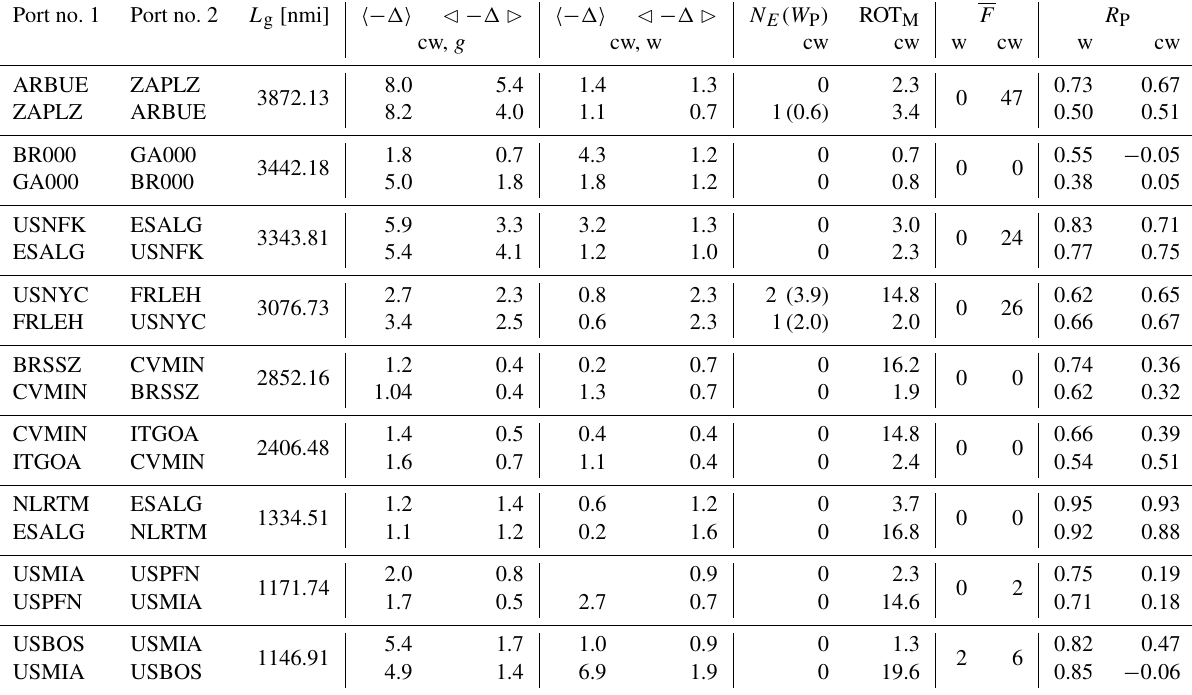
Table 7. Database of routes. L g is the length of the geodetic track on the graph. (cid:49) is a shortcut for the EEOI saving. The (cid:104)·(cid:105) operator denotes the annual mean. The (cid:67) · (cid:66) is the mean annual value of the standard deviation. Corresponding values are given (in %). The second header line specifies the type of tracks. The other columns contain the number of tracks N E with intentional speed reduction and the maximum percent fraction of track waypoints affected (W P ) – for the w type this figure is always 0 except for the ZAPLZ–ARBUE route, where it reads 1(0.4). The maximum rate of turn ROT M ( ◦ min − 1 ), the number of non-FIFO edges F (neither of them is along the optimal track), and the Pearson coefficient R P between T ∗ and L are shown. The DOF varies from more than 5 . 4 × 10 8 of the ARBUE–ZAPLZ to about 2 . 5 × 10 7 of the